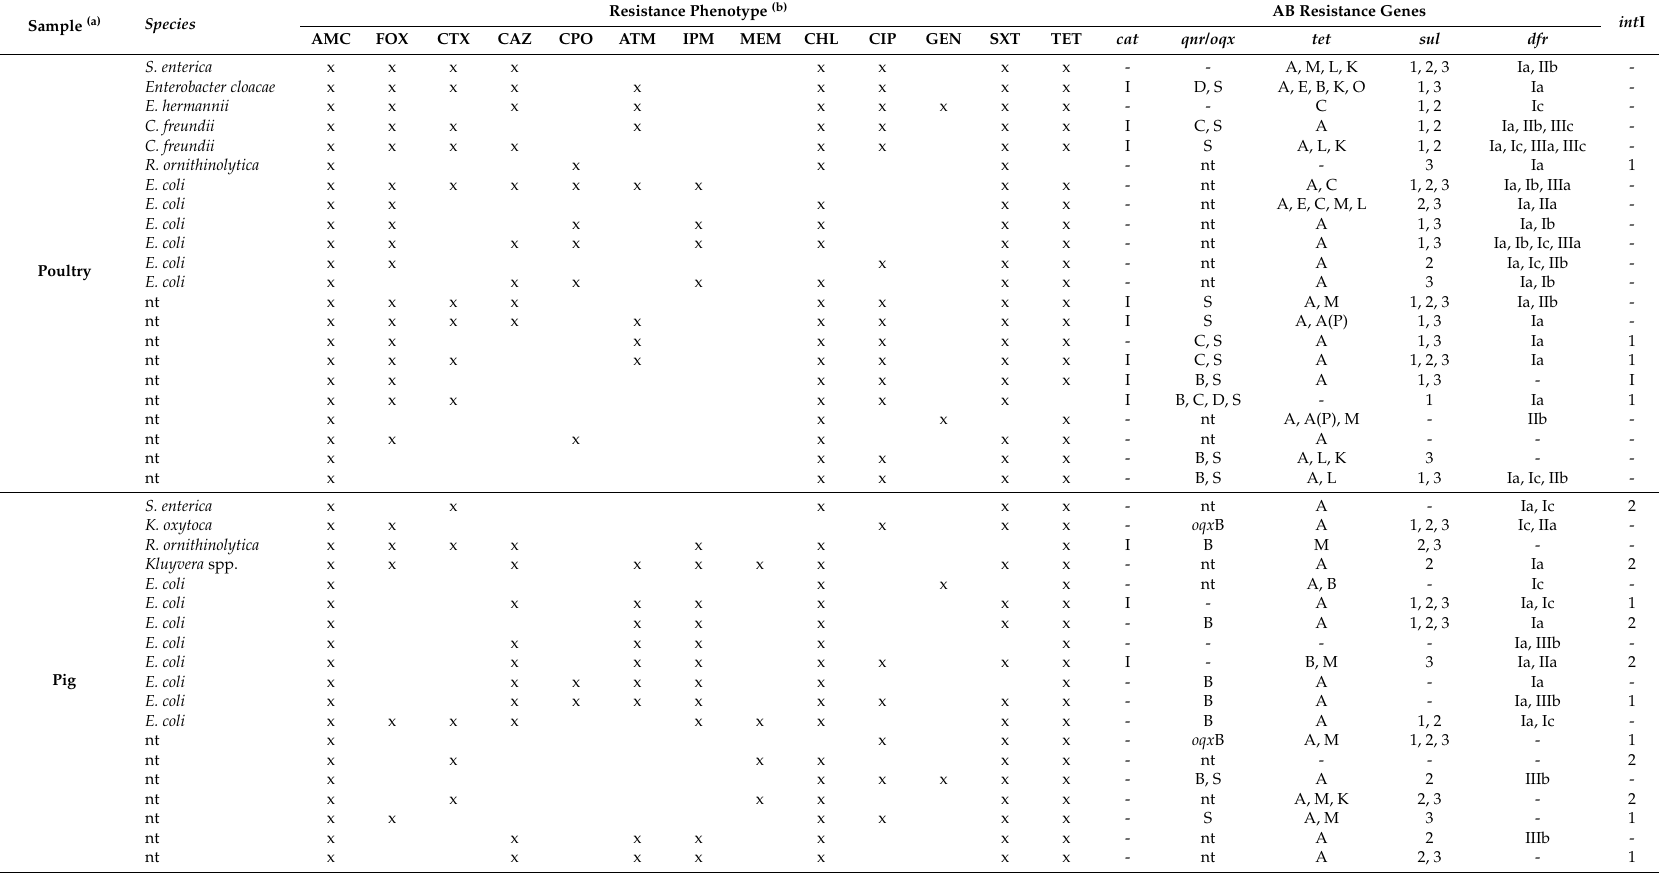
Table 2. List of AB resistance profile, AB resistance and integrons genes harboured per isolate species and sample